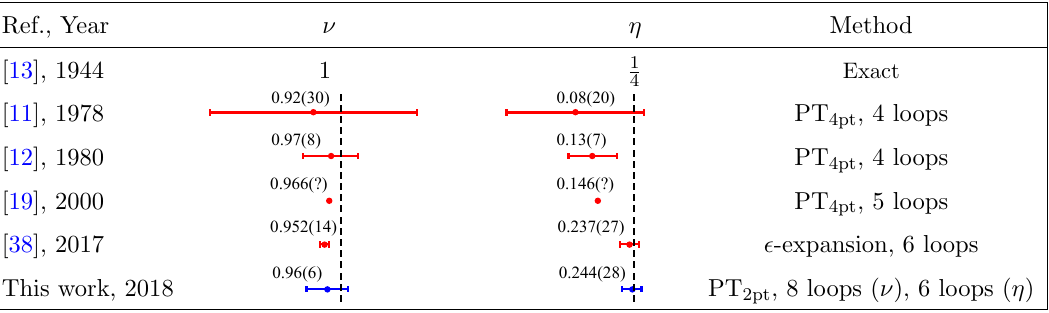
Table 7 . Comparison of the critical exponents (cid:23) and (cid:17) computed using di(cid:11)erent resummation techniques at di(cid:11)erent orders. See the main text for further